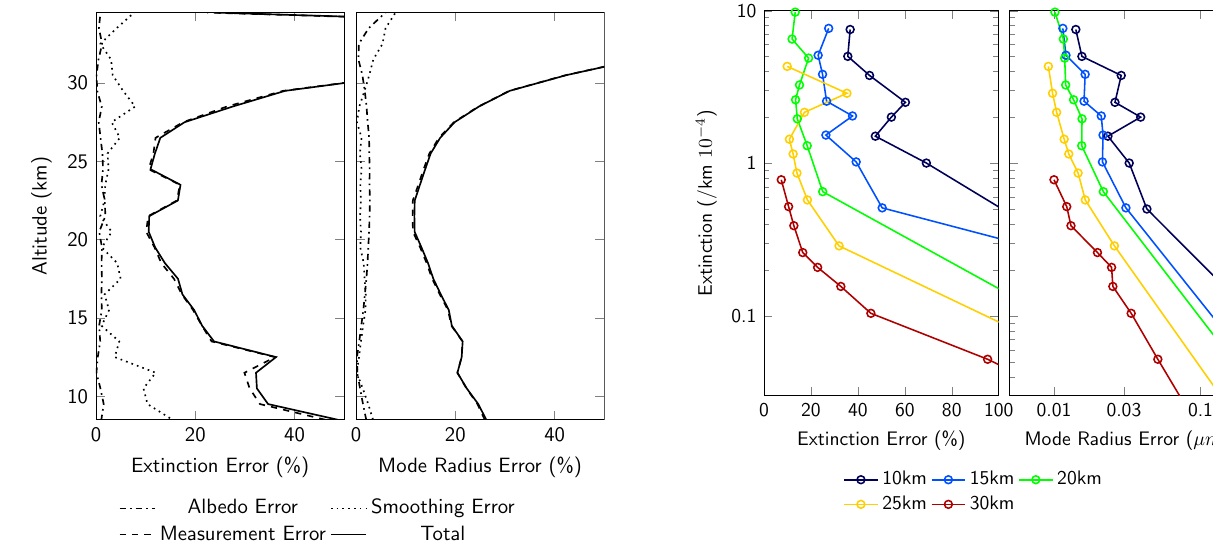
Total Fig. 9. Total relative error in the retrieved quantities due to albedo, smoothing and measurement error contri- butions for a simulated measurement with a solar scattering angle of 61 ◦ and a solar zenith angle of 89 ◦ . The aerosol profile used in the simulation was typical of background conditions with a mode radius of 80nm and